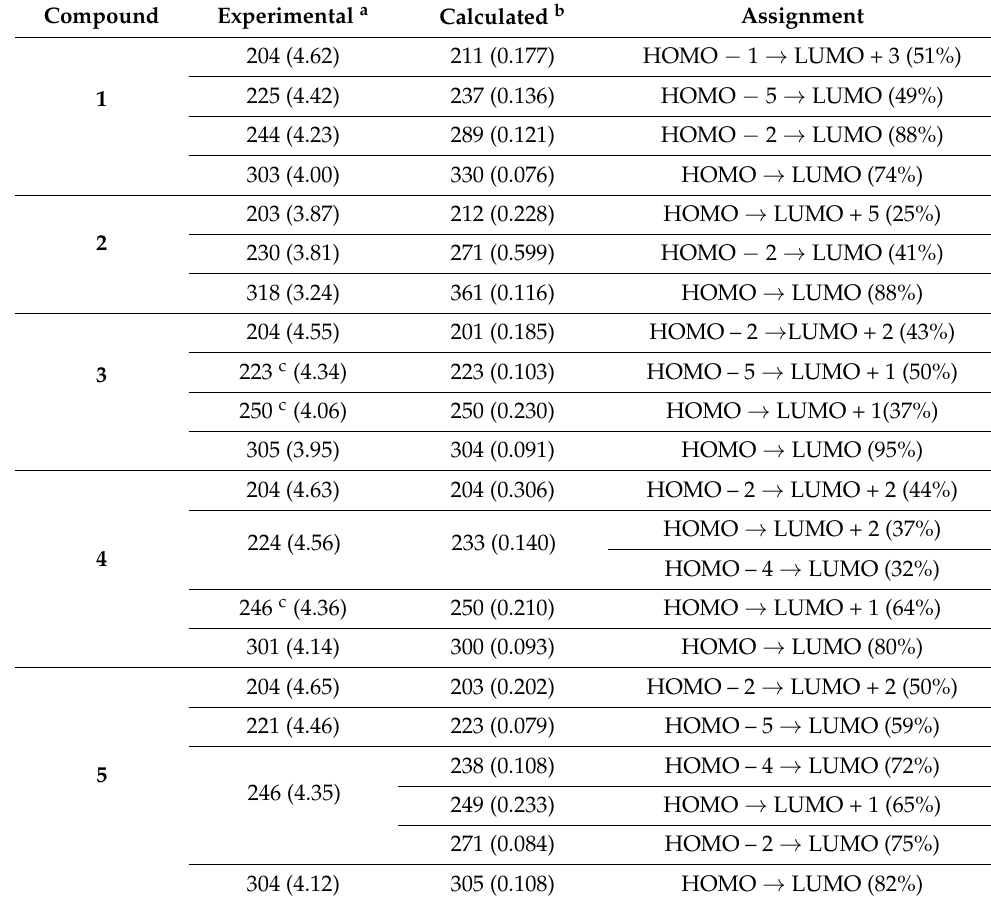
Table 3. Experimental and calculated (B3LYP/6-311++G(d,p) electronic spectra of 1 – 5 . Compound Experimental a Calculated b Assignment 204